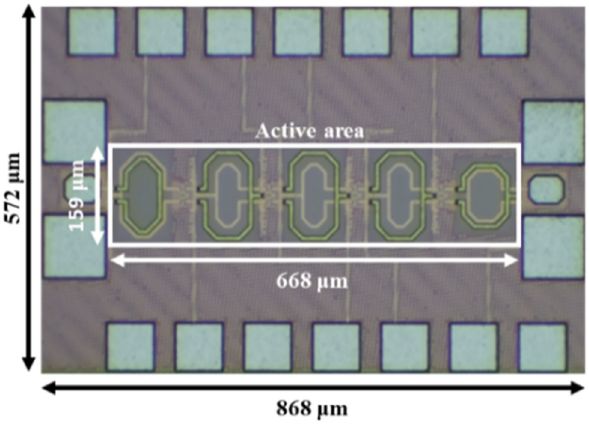
Figure 9. Photograph of the fabricated four-stage variable-gain amplifier (VGA).